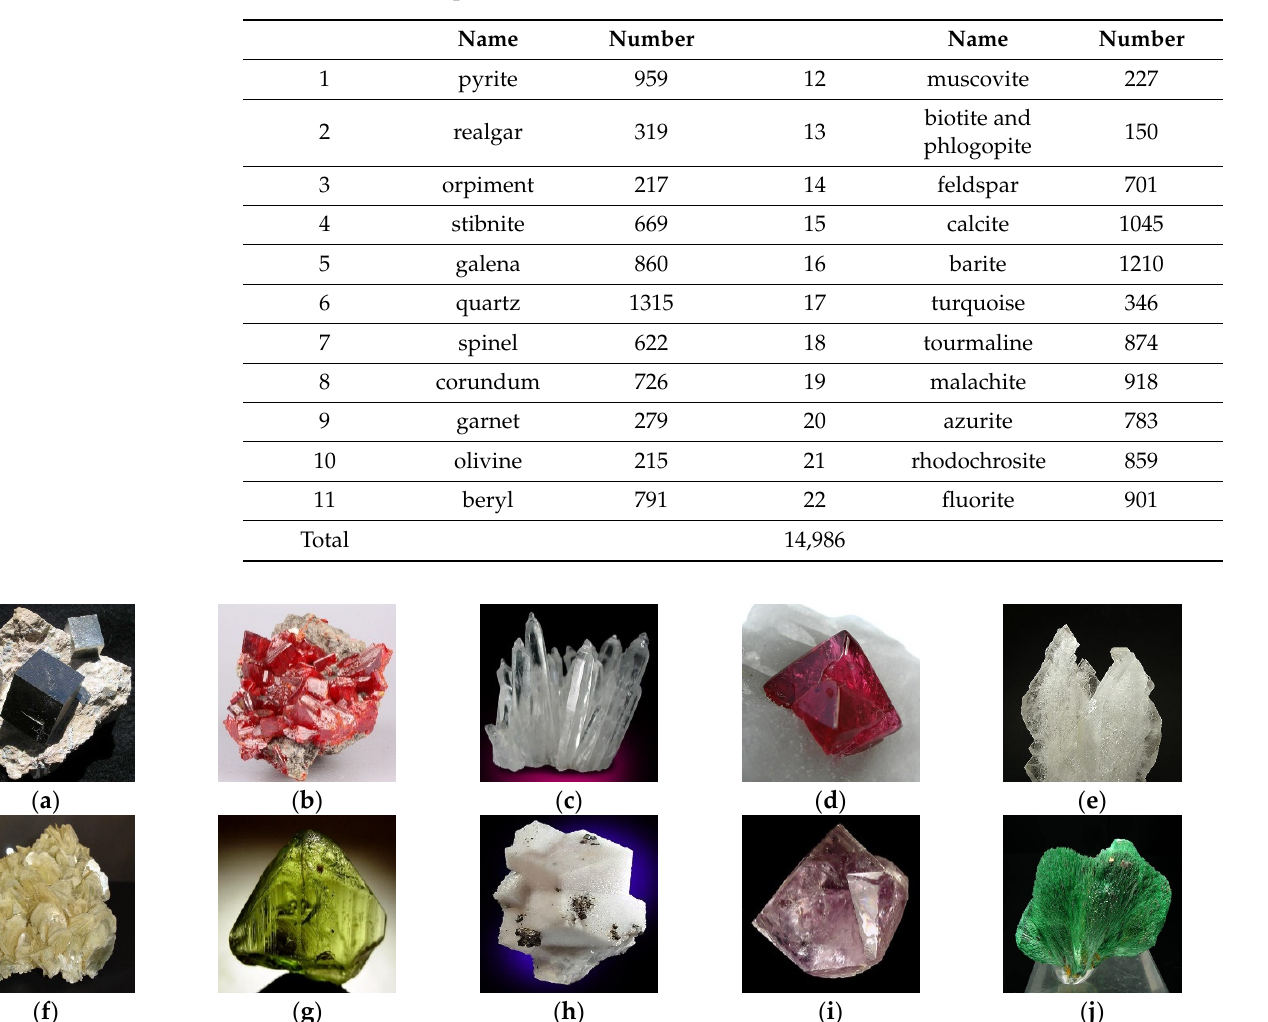
Table 2. Names and quantities of minerals in the dataset.